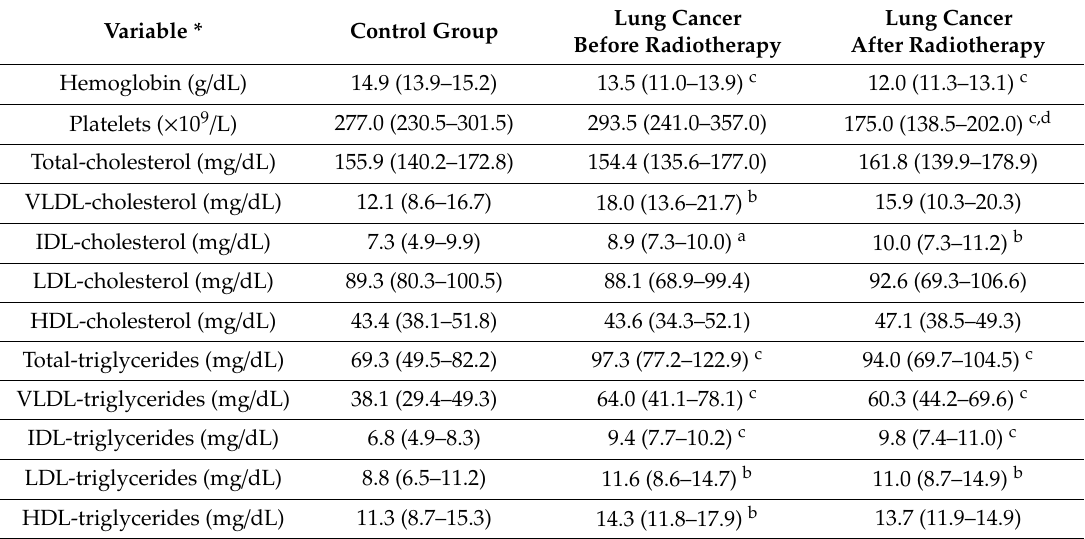
Table 4. Hematological variables and plasma cholesterol and triglycerides concentrations in lung cancer patients before and after radiotherapy.